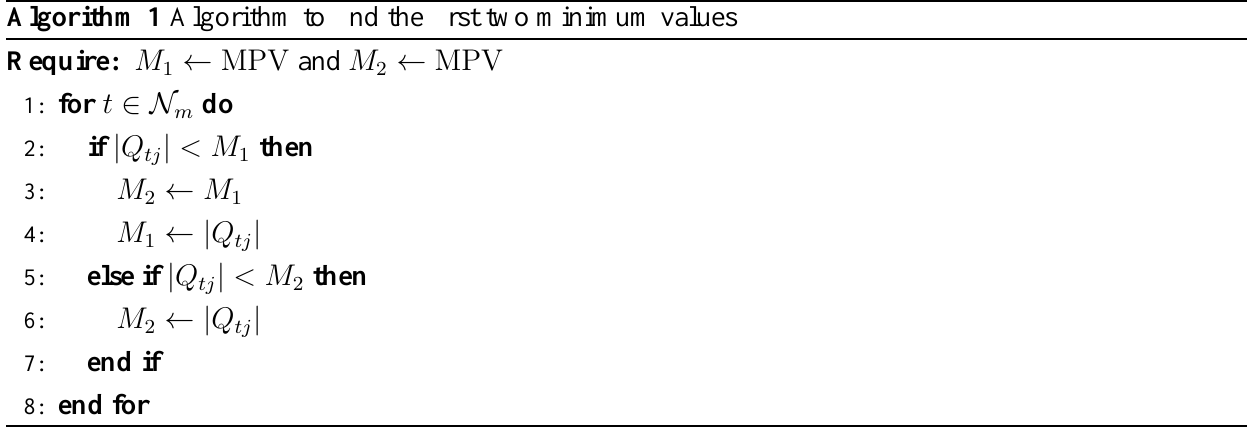
Algorithm 1 Algorithm to find the first two minimum